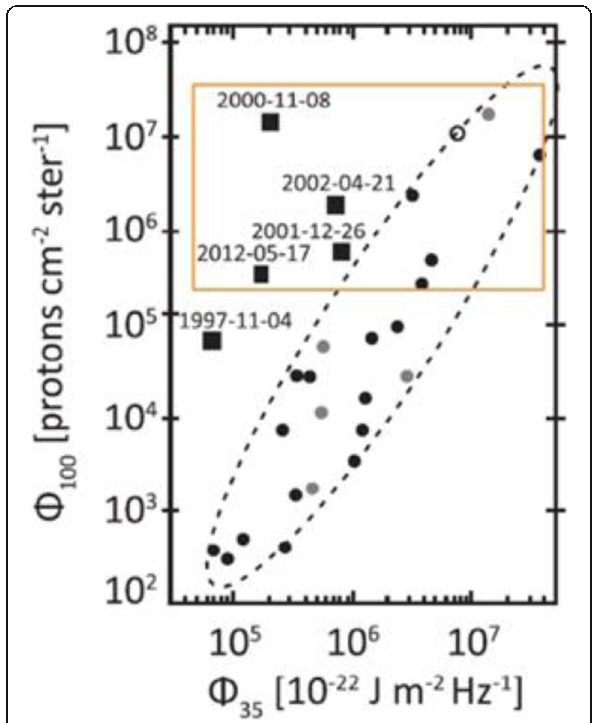
Fig. 22 Scatterplot of longitude-corrected > 100 MeV proton fluence ( Φ 100) vs. 35 GHz fluence ( Φ 35) for solar proton events from 1996 to 2014; black circles and squares (W21 – W90); gray circles (E30 – W20); open circles (< E30). The orange rectangle isolates events with Φ 100 > 2 × 10 5 pfu (from Cliver